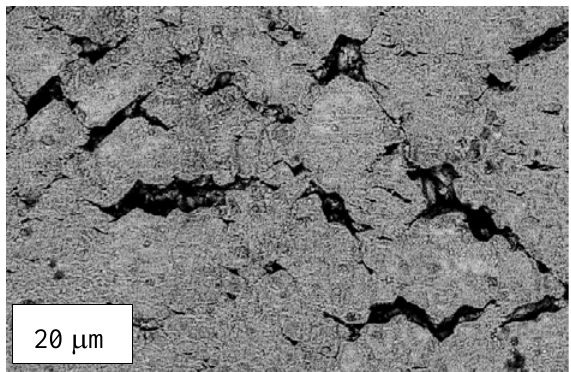
Figure 19. Multiple intergranular crack initiation along the gauge surface of a specimen tested at 750 °C.